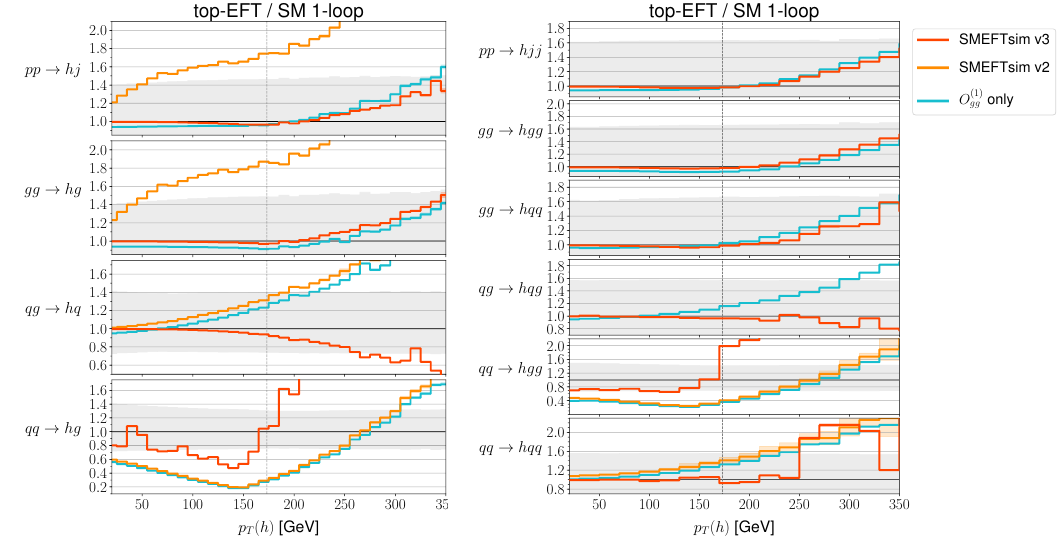
Figure 1 . Top-EFT predictions for dσ/dp T ( h ) in pp → hj (left) and pp → hjj (right), normalized to the SM 1-loop results, see text for the calculation details. In both figures, the first panel shows the combined result, while the lower ones give the breakdown into the contributing channels. Note that here q generically denotes a light quark or antiquark. The statistical uncertainties are plotted in color, and they are not visible in most cases. For reference, the gray bands show the systematic uncertainty on the SM event generation and the vertical dashed line marks p top-EFT is expected to break down. SMEFTsim v2 curves for pp → hjj , gg → hgg , gg → hqq , qg → hqg lie above the plotted